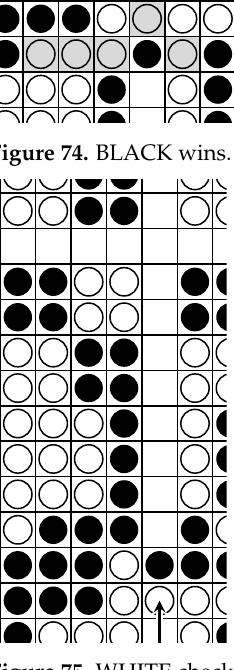
Figure 74. BLACK wins.